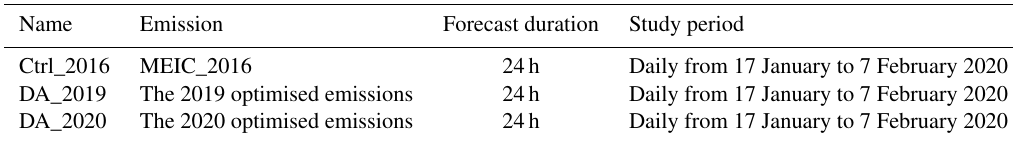
Table 3. Details of the forecast experiments using emissions from 2016, 2019, and 2020.